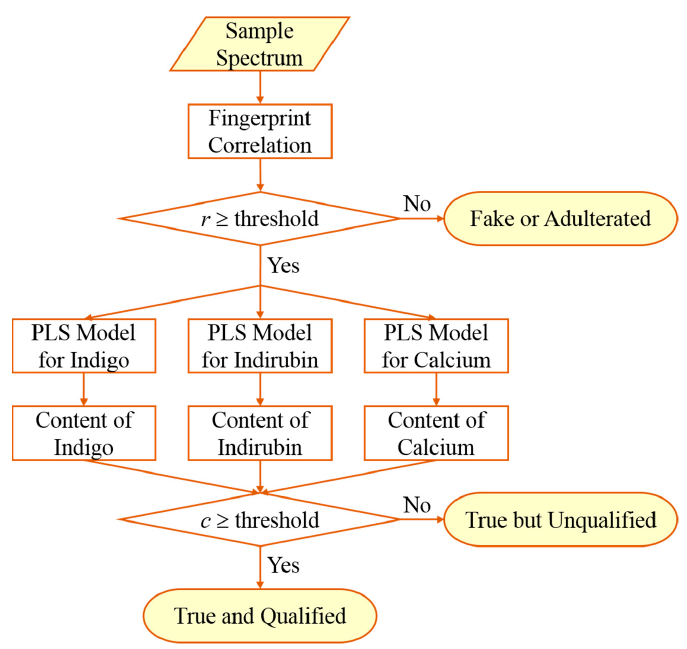
Figure 1. Algorithm of the integrated quality assessment of Indigo Naturalis by FTIR spectroscopy.